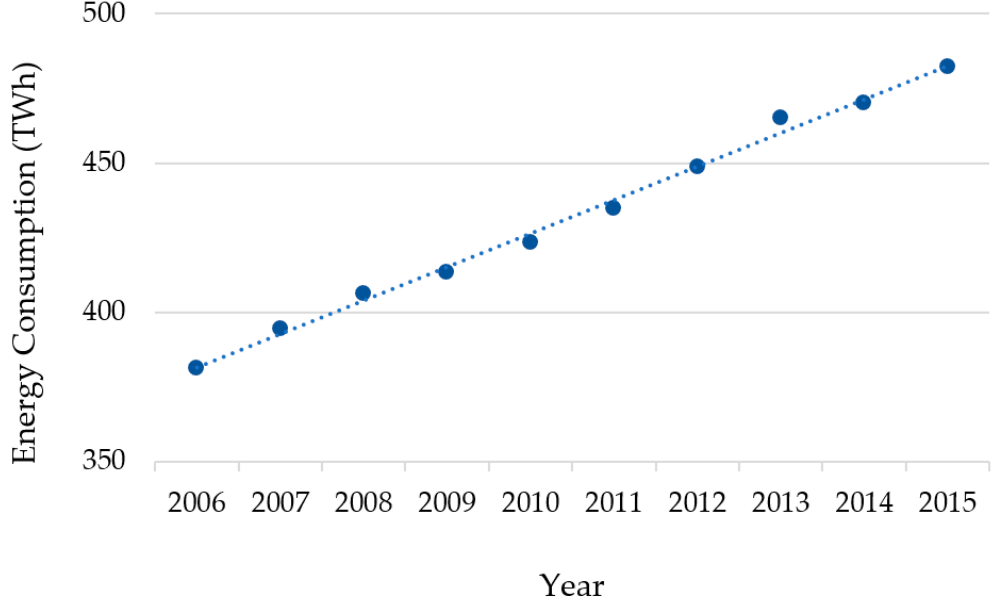
Figure 14. Buildings energy consumption in Pakistan, showing an annual average increase rate of +2.9% over the years 2006–2015